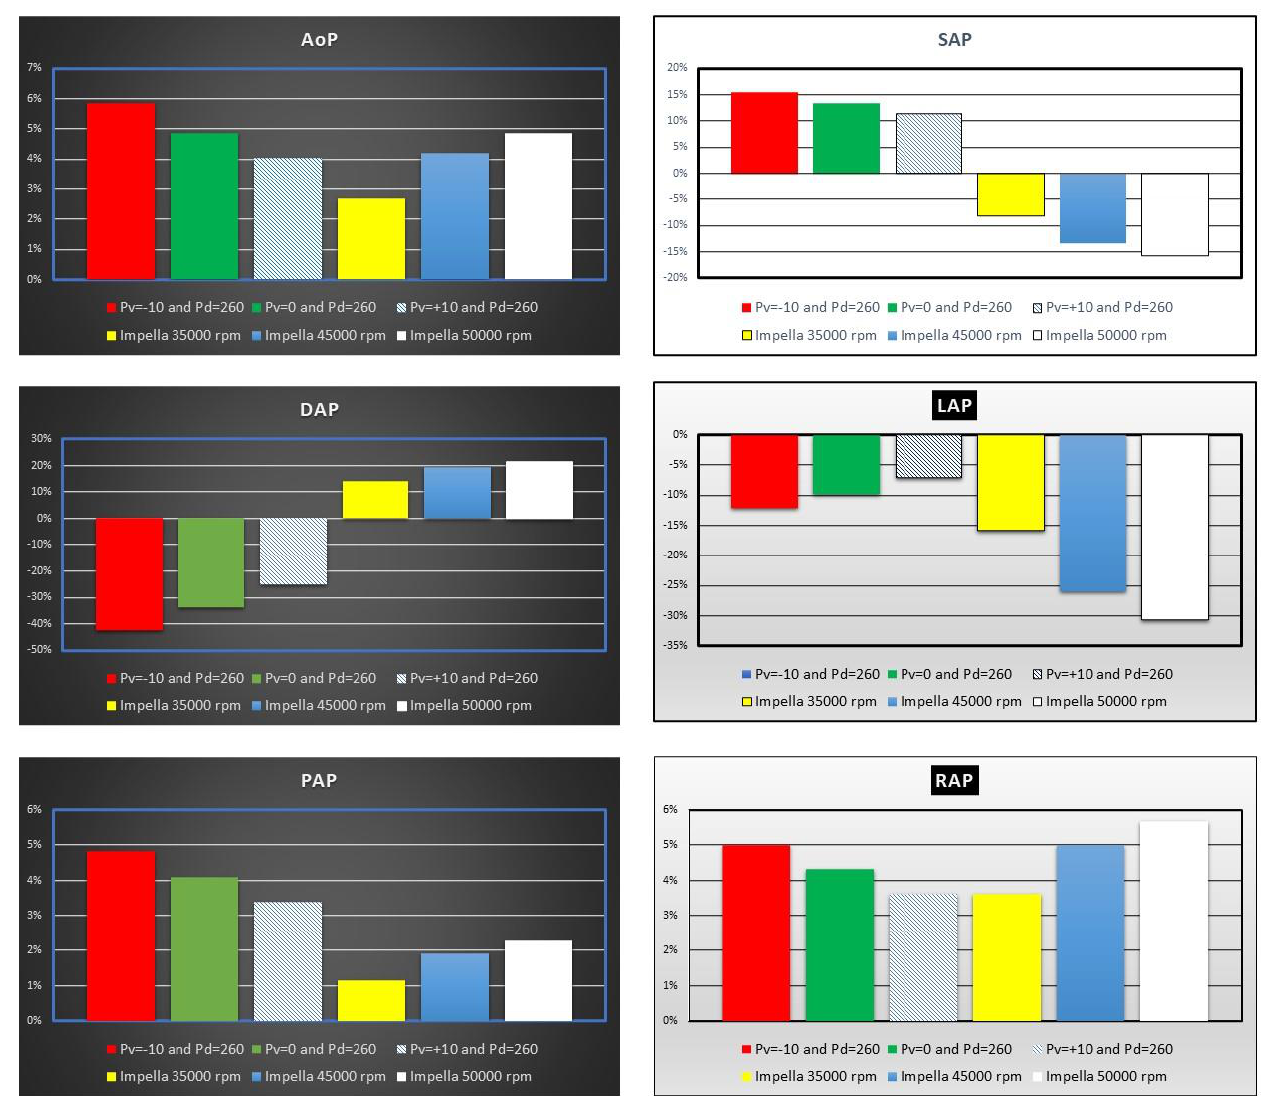
Figure 6. Percentage change calculated in comparison to baseline conditions for mean aortic pressure (AoP), systolic and end-diastolic aortic pressure (SAP and DAP), mean left atrial pressure (LAP), mean pulmonary arterial pressure (PAP) and mean right atrial pressure (RAP) when IABP or Impella 2.5 support were simulated. The simulation settings included LVAD rotational speed at 35,000, 45,000 and 50,000 rpm and IABP with Pv = − 10, Pv = 0 and Pv = +10 mmHg, and Pd = 260 mmHg.